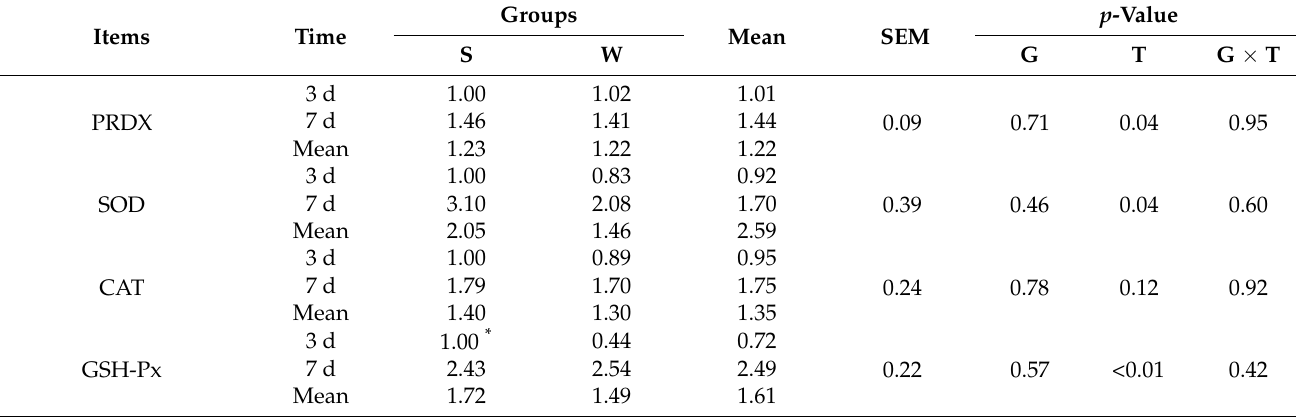
Table 6. Effects of weaning on the gene expression of antioxidant enzymes in the liver of